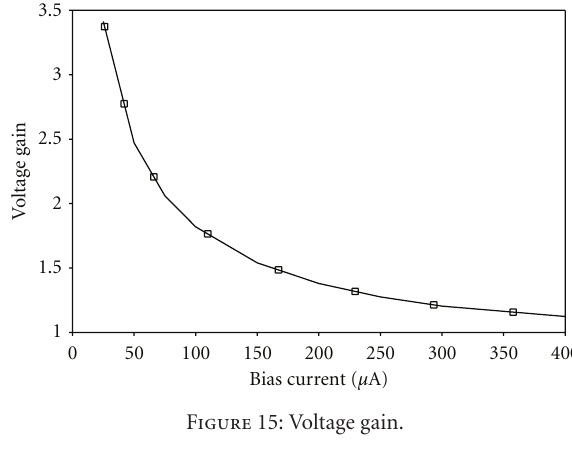
Figure 15: Voltage gain.